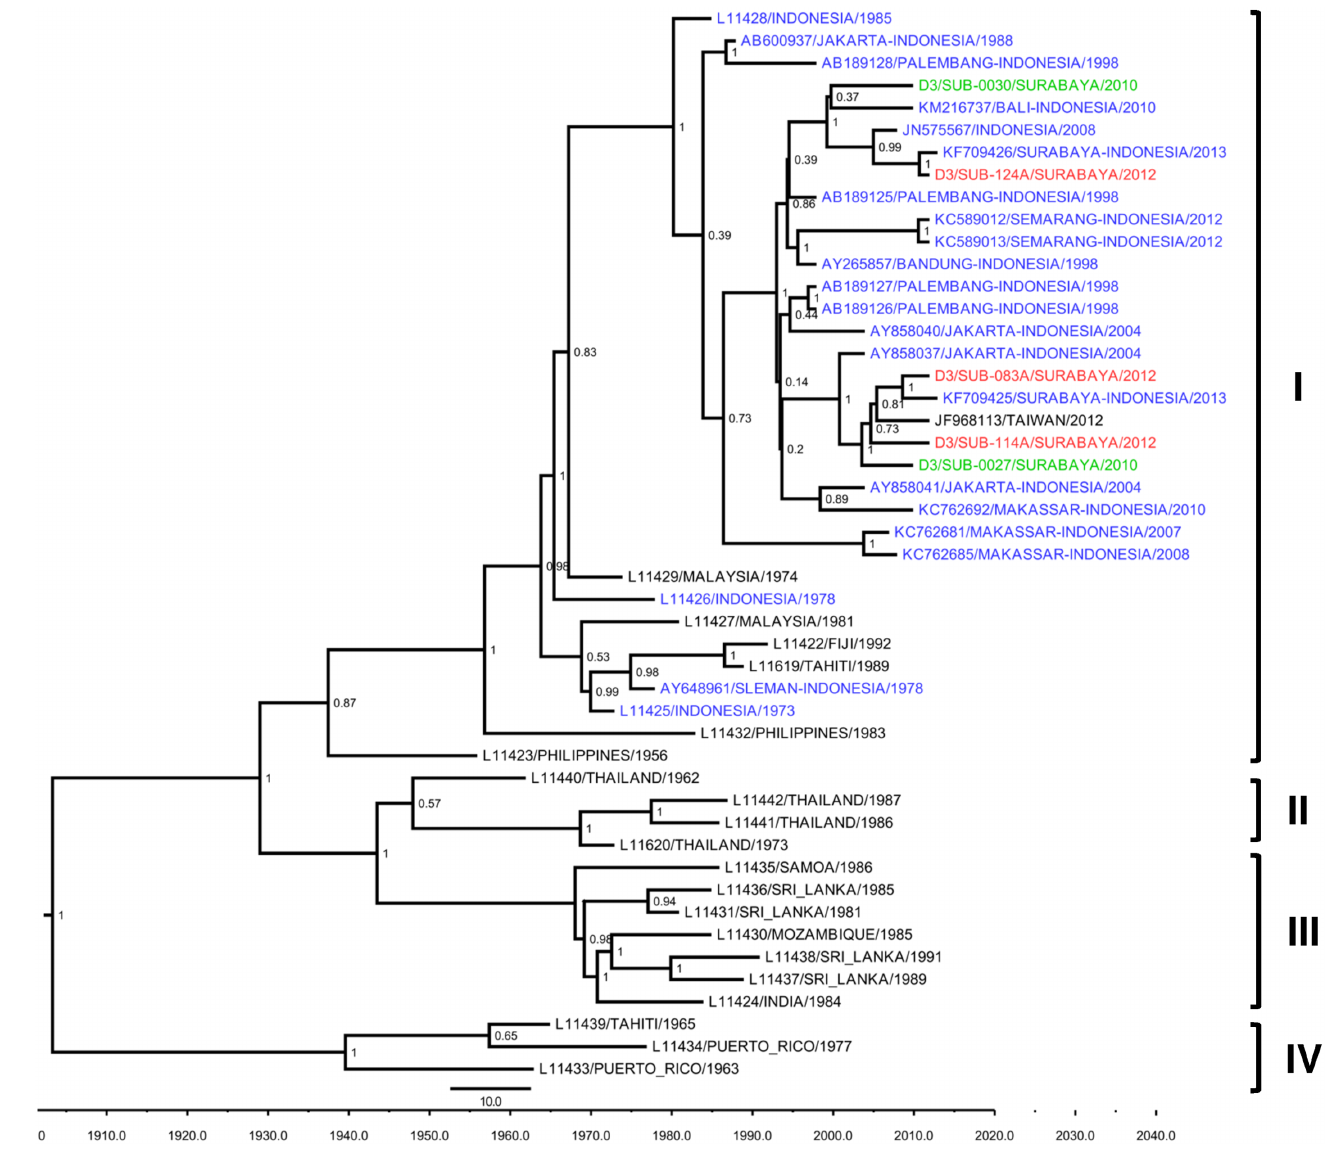
Fig 4. MCC tree of DENV-3 genotype groupings generated by Bayesianinference method as implemented in BEAST using GTR evolution model and gamma parameter rates from the E gene sequences. The Surabaya2012isolates (red font) were groupedinto Genotype I basedon classificationby Lanciotti et al [29], together with isolates from Surabaya 2010 (green font) and other cities in Indonesia(blue font). The posterior probabilities of the clades are indicatedas numbersin the node labels.